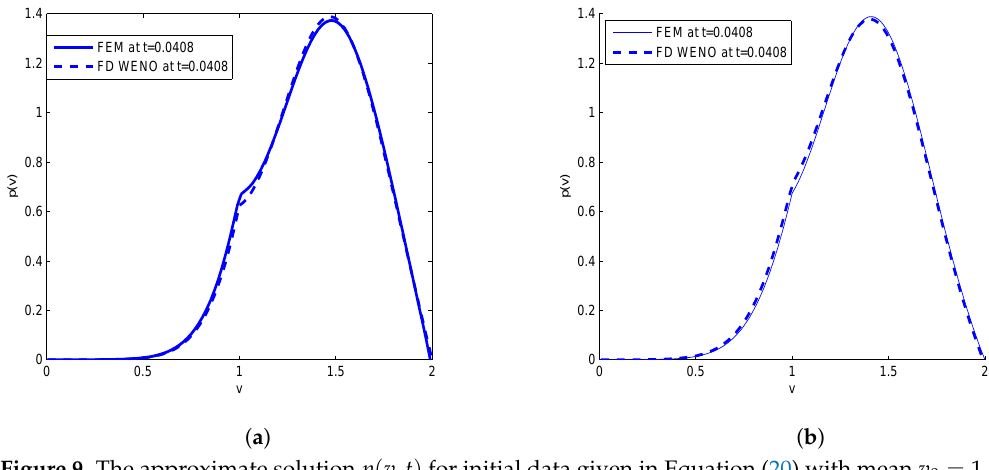
Figure 9. The approximate solution p ( v , t ) for initial data given in Equation (20) with mean v 0 = 1.5 = 0.005 and with activity dependent noise a ( N ( t )) = 1 + N ( t ) /100. Left: The system and variance σ 2 0 is considered for the excitatory case i.e., by taking b = 0.5 > 0; Right: The system is considered for the inhibitory case i.e., by taking b = − 0.5 <